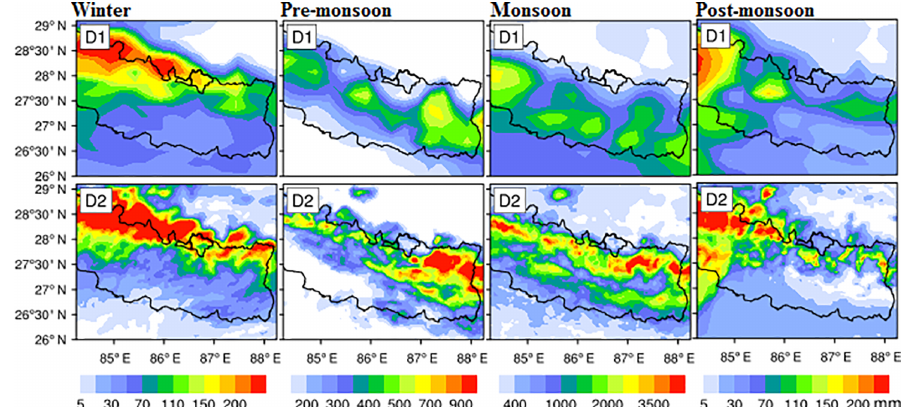
Figure 10. Seasonal distribution of precipitation in larger area in D2 and D1 domain